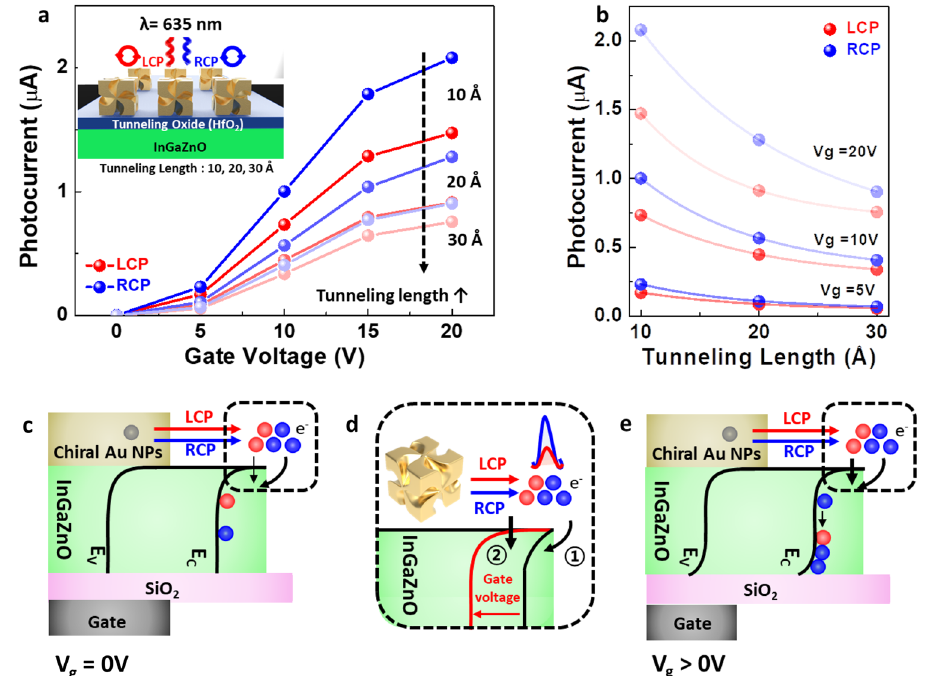
Fig. 5 | Photocurrent of the CPL-detecting transistor with a tunneling oxide, and suggested hot electron transport mechanism depending on the gate vol- tage. a Photocurrent of the CPL-detecting transistor under 635nm CPL illumina- tion when the device hasatunneling HfO 2 fi lmof variousthickness atthe interface between the chiral gold nanoparticles and InGaZnO layer. b Corresponding